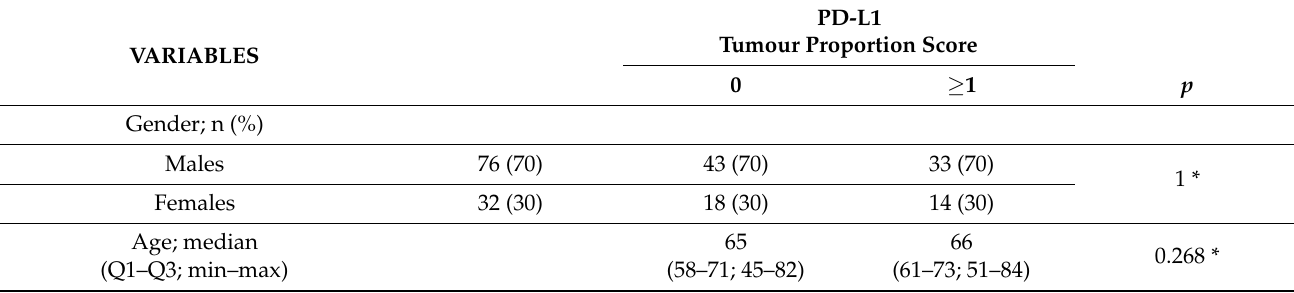
Table 1. The correlation of analysed variables with PD-L1